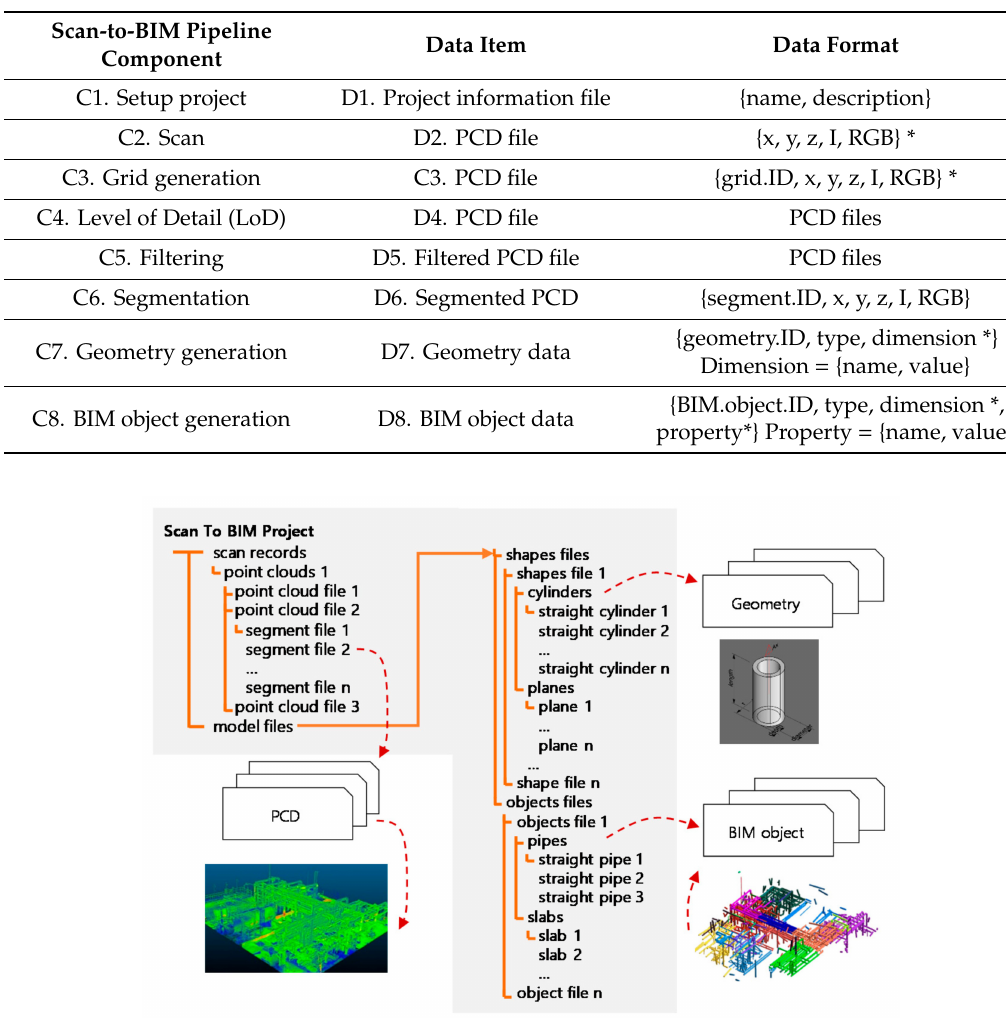
Table 1. Scan-to-BIM pipeline component and input / output data derivation (* = multiple).